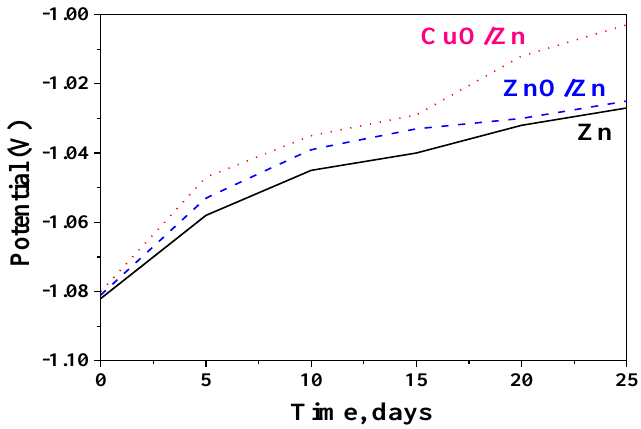
Figure 5. Open circuit potential (OCP) measurements of ordinary Zn and both hybrid coatings in the model corrosive medium of 5% NaCl.